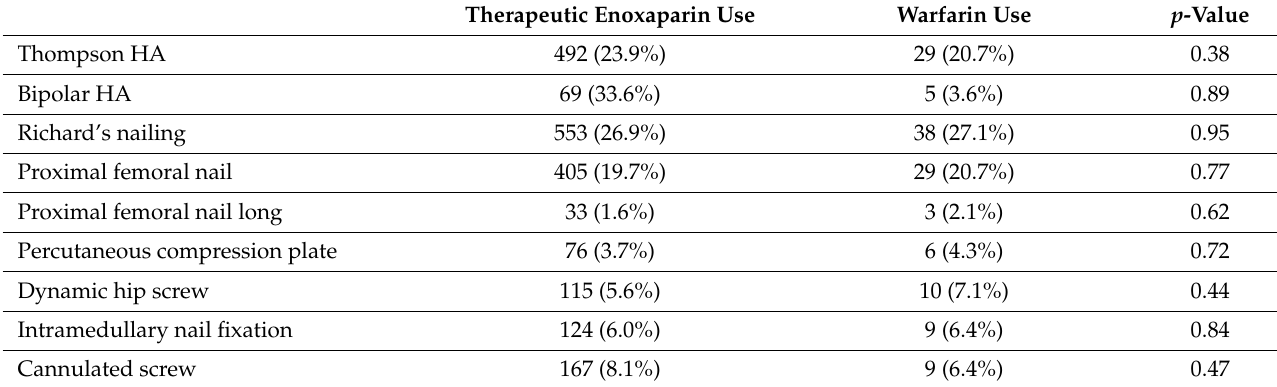
Table 3. Type of surgical fixation and diagnosis between cohorts.